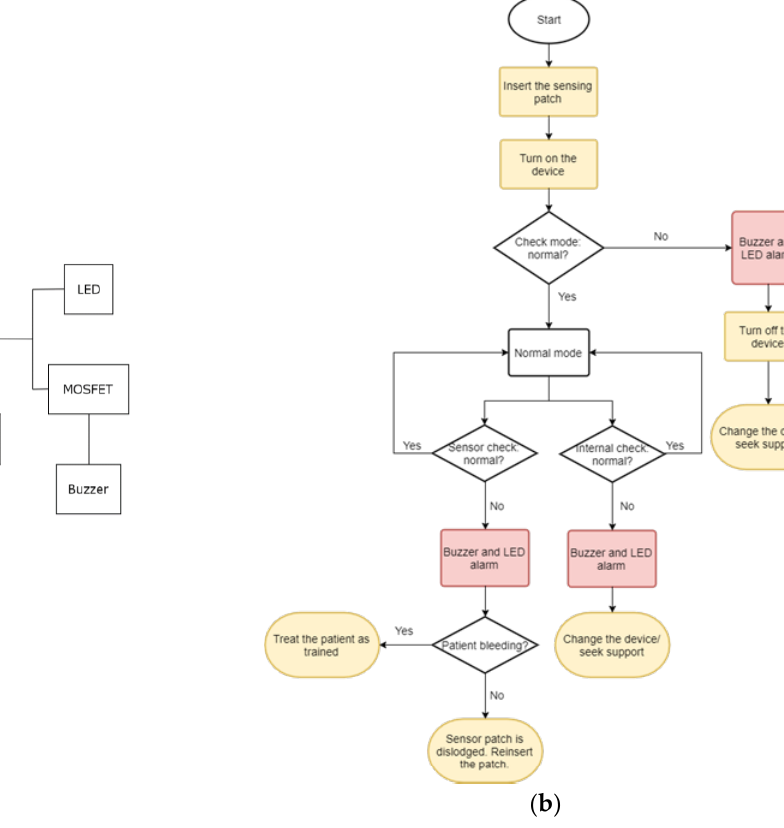
Figure 3. ( a ) Block diagram of hardware circuit design, featuring low power consumption and miniaturized wearable style. ( b ) Flow chart of software design. One-button start-up sensing mode was adopted to make it more convenient and time-saving for medical staff.